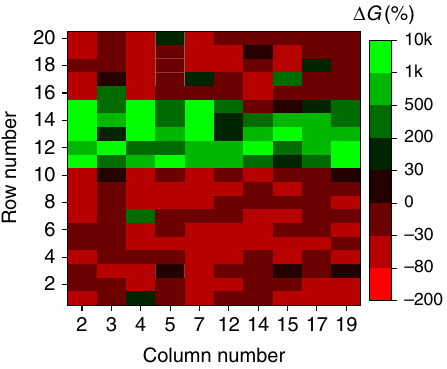
Fig. 7 Column statistics. The relative change in device conductances after 20 epochs of applying synchronous input to rows #11 through #15, when connecting LIF neuron to a speci fi ed column in the crossbar. The experiments were performed separately for each column. p spike = 1, ( t jitter ) max = 5 ms, ( Δ offset ) max = 27 ms. The noise spikes were always generated randomly for each row in all frames